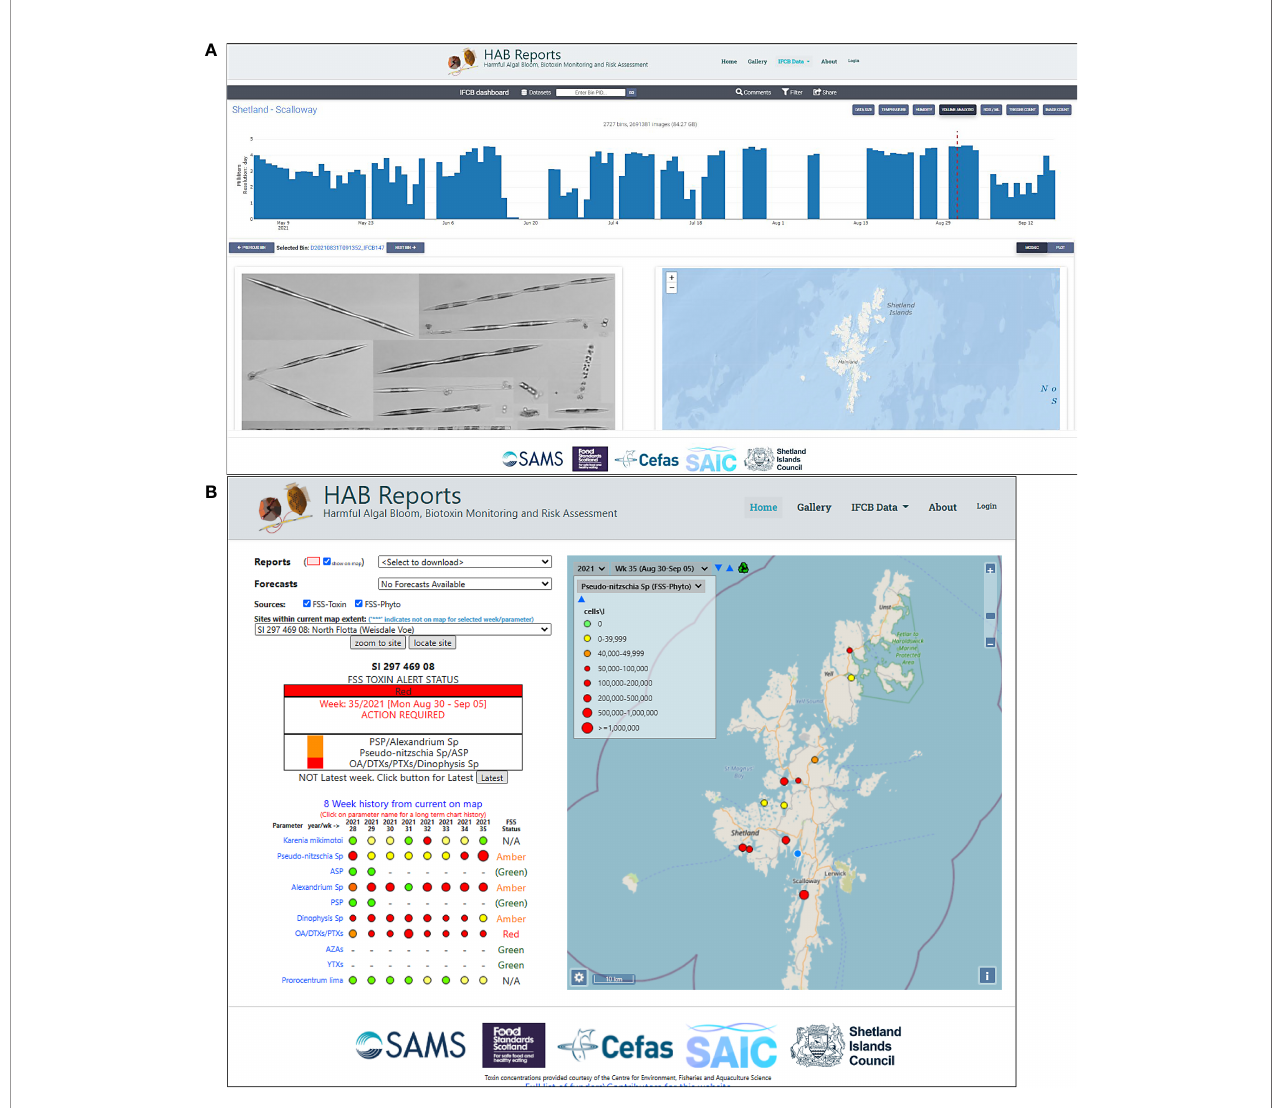
FIGURE 7 | HABreport portal (https://www.habreports.org/) snapshots: (A) interface for viewing and interrogating IFC data from Scalloway, showing the 31st August 2021 IFC image of largest phytoplankton (mainly Pseudo-nitzschia spp.) and (B) HABreports display (see Davidson et al., 2021) showing alert levels based on HAB species concentrations and toxin analysis for the current (week 35, Aug 30 - Sep 05) and previous weeks at the North Flotta HAB monitoring site (blue circle). Green/amber/red are Food Standards Scotland (FSS) “ Toxin Traf fi c Light Guidance ” levels that indicate the harvesting action and testing considerations that should follow (N/A, no